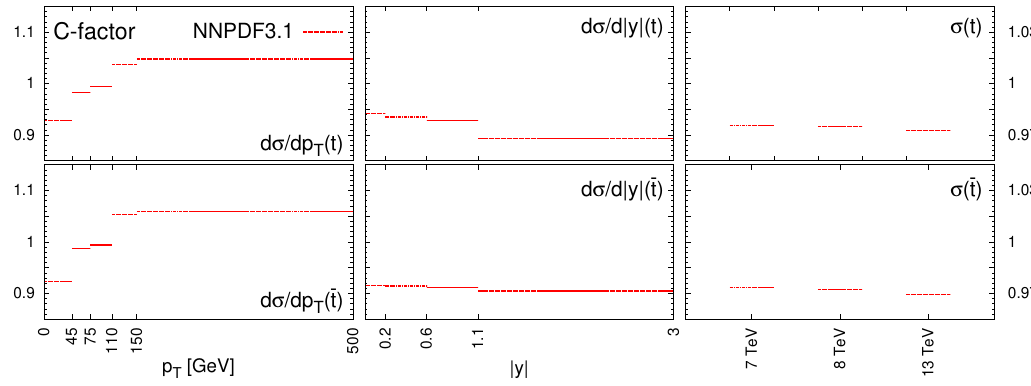
Figure 1 . The C -factors, eq. (3.1), computed with the NNPDF31 nnlo as 0118 PDF set, for the distributions di(cid:11)erential in the transverse momentum (left), in the absolute rapidity (centre), and for the total cross sections (right) of top-quark (top) and top-antiquark (bottom). Results are displayed at 7 TeV for di(cid:11)erential distributions, and at 7, 8, and 13 TeV for total cross sections. Note that the scale on the vertical axis varies: it ranges from 0.9 to 1.1 for the transverse momentum distributions, while it ranges from 0.97 to 1.03 for the rapidity distributions and for the total cross